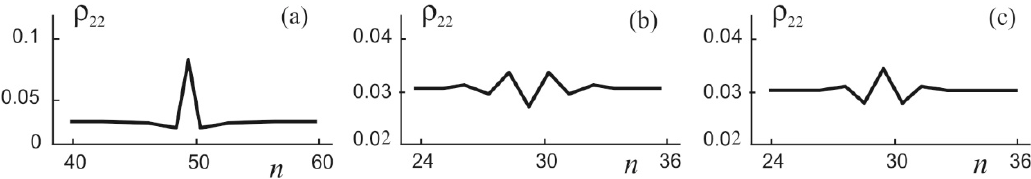
Figure 7. Profiles of population of the excited state for time moments t = 0 ( a ), 50 ( b ), 300 ( c ), and 700 ( d ), see the text.